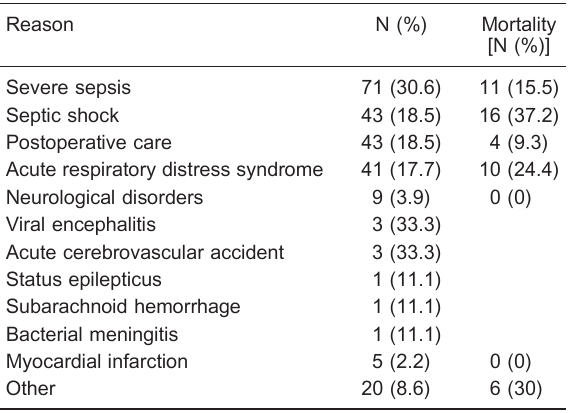
Table 3. Reasons for admission to the intensive care unit and mortality of critically ill patients.